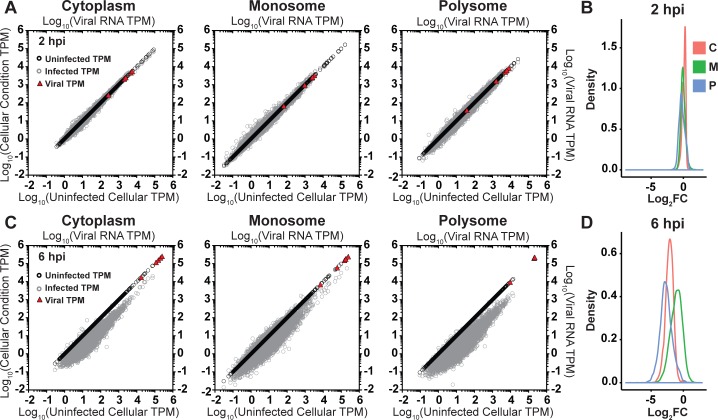
The relative abundance of individual cellular mRNAs in the cytoplasm and on polysomes decreases between 2 and 6 hpi.(A) Scatter plots of Transcripts per Kilobase Million (TPM) for exonic regions at 2 hpi. The TPM in uninfected cells for a given mRNA is graphed on the abscissa, and the TPM for a given cellular mRNA in either uninfected (black circles), or VSV infected cells (gray circles) is graphed on the ordinate. The viral mRNAs are indicated by the red triangles. (B) Density plots of the log2 fold change in TPM for cellular mRNAs between uninfected or VSV infected cells at 2 hpi. C, M, and P denote “cytoplasm”, “monosome”, and “polysome”, respectively. (C) Scatter plots of TPMs for individual mRNAs at 6 hpi, presented as in A. (D) Density plots of the log2 fold change in TPM at 6 hpi, presented as in B.